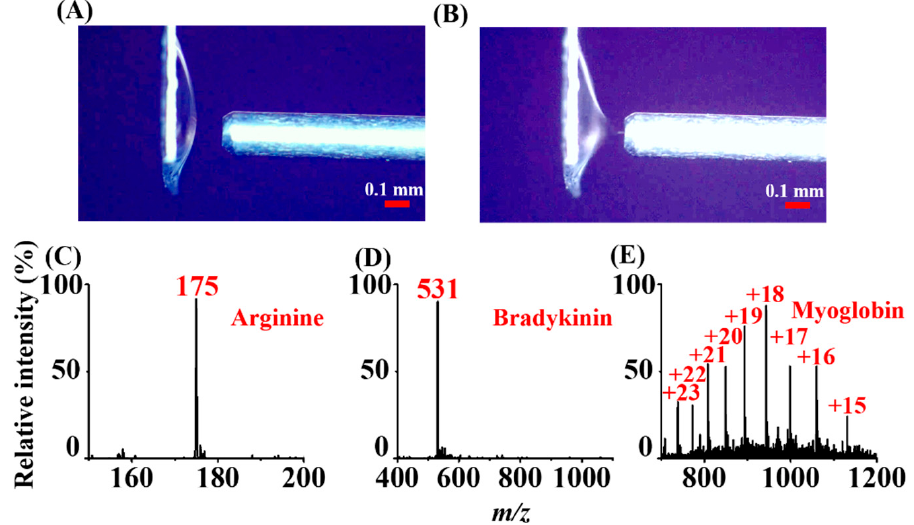
Figure 6. Photographs of a sample droplet deposited on a titanium slab (0.3 cm × 0.3 cm) obtained ( A ) before and ( B ) after applying the high voltage ( − 4500 V) to the inlet of the mass spectrometer. ASAI mass spectra obtained from individual sample droplets (2 µ L) containing ( C ) arginine ([M + H] + = 175), ( D ) bradykinin ([M + 2H] 2+ = 531), and ( E ) myoglobin (MW = 16,950 Da) deposited on the titanium slab (0.3 × 0.3 cm) followed by ASAI–MS analysis through the ESI-like